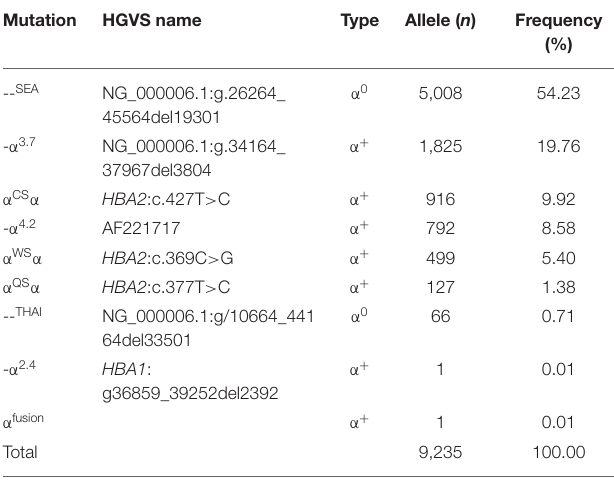
TABLE 3 | Allele frequency of α -thalassemia among the 71,459 children in Guangxi. Mutation